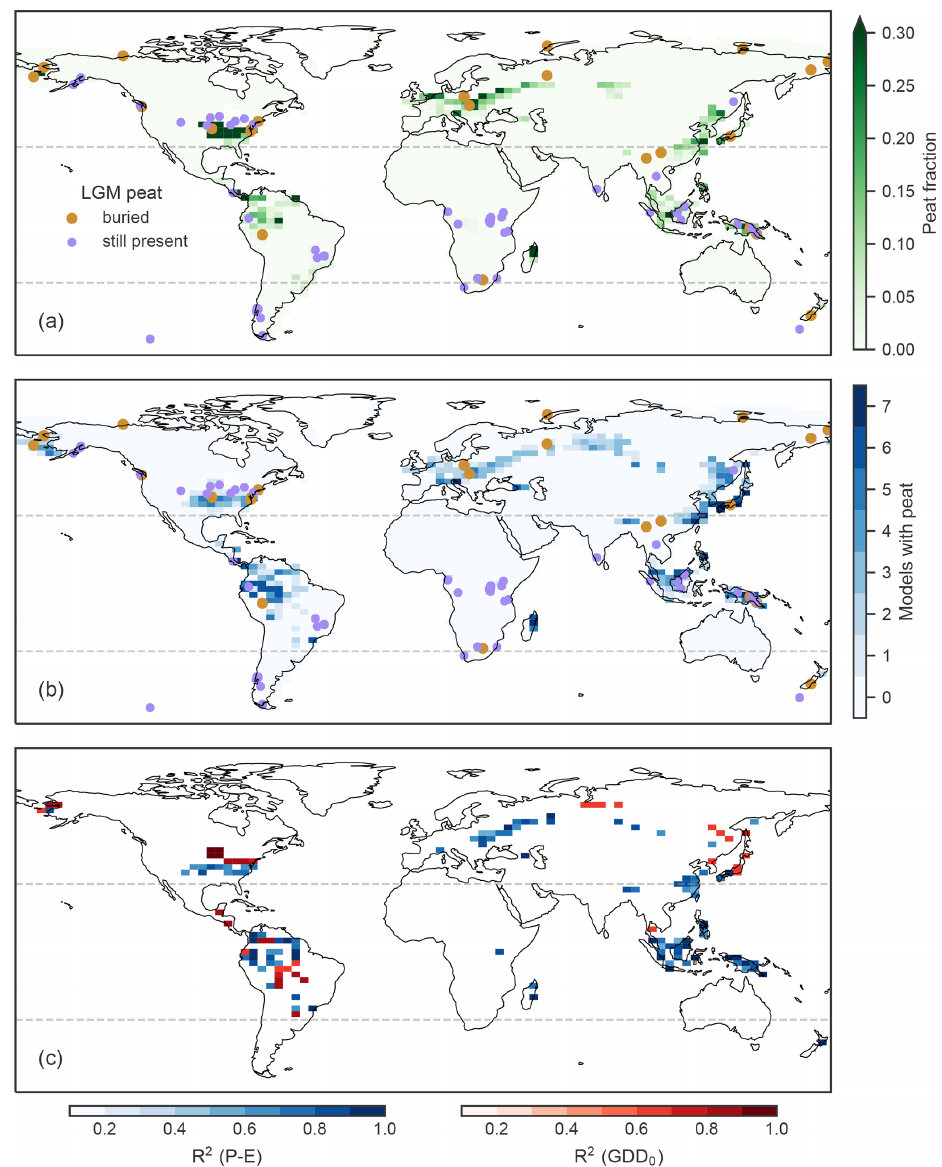
Figure 2. Peatland distribution at the Last Glacial Maximum (LGM) as simulated by LPX-Bern in the standard setup (a) , agreement (as number of models simulating peat in given grid cell) between LGM time slice simulations run with LPX and forced with different climates anomalies from six PMIP3 models as well as the TraCE21k anomaly (b) , and the squared correlation coefficient for a linear regression between physical properties of the different time slice simulations (precipitation minus evapotranspiration, P − E, and growing degree days above 0 ◦ C ) and peat fraction in the respective cells. Only cells with significant correlation ( p > 0 . 05) are plotted. The colored shading in panel (b) indicates how many time slice simulations show a peat fraction of > 0 . 05 in the respective cell. The color code in panel (c) denotes the dominant predictor in the respective cell. Dots in panels (a) and (b) show buried and still active peat deposits that indicate active peat accumulation during the LGM (24.5–17.5kyrBP). Peat core data are from Treat et al.